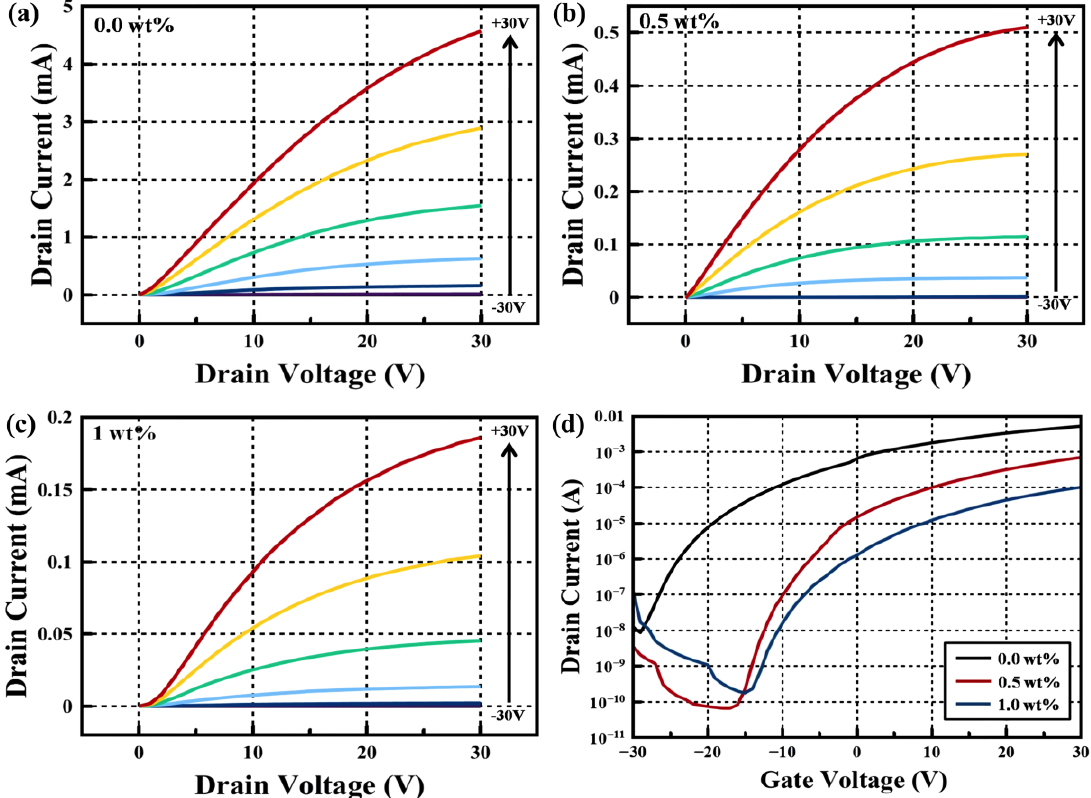
Figure 4. Output curves of solution-processed SnO 2 TFTs with Mg doping concentration ( a ) 0.0 wt% ( b ) 0.5 wt% and ( c ) 1 wt% and ( d ) I D -V D curves of samples with 0.0 wt%, 0.5 wt%, and 1.0 wt% Mg.